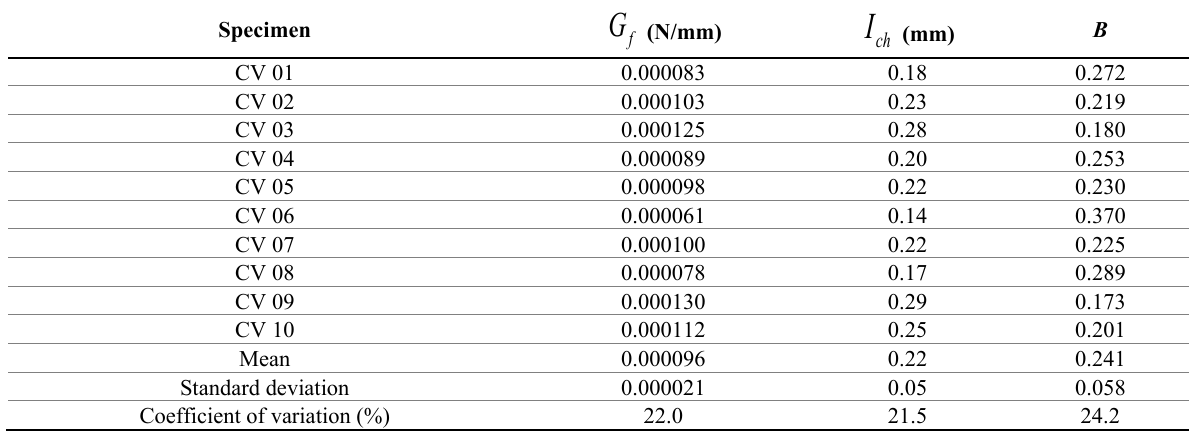
Table 3. Conventional concrete characteristic length and